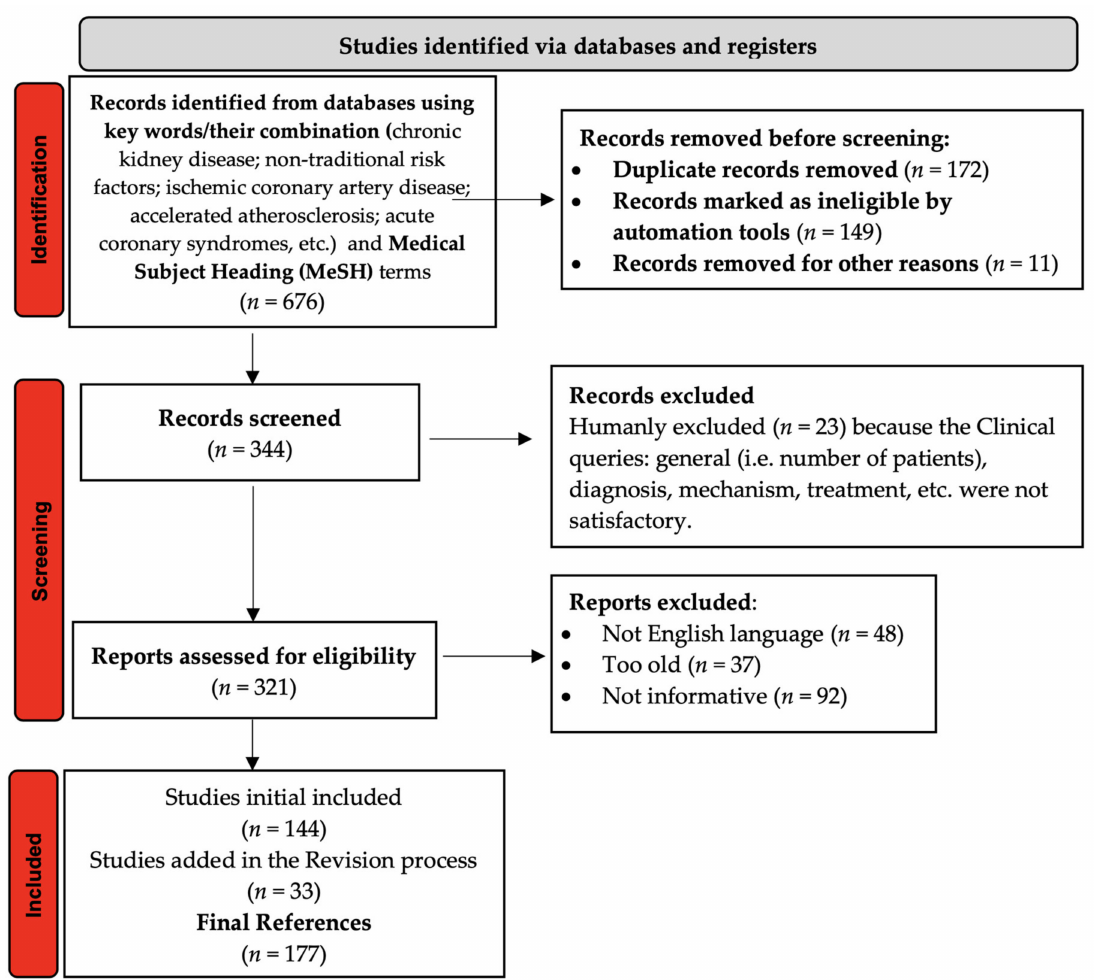
Figure 1. Flow chart on the selection process of bibliographic sources included in this